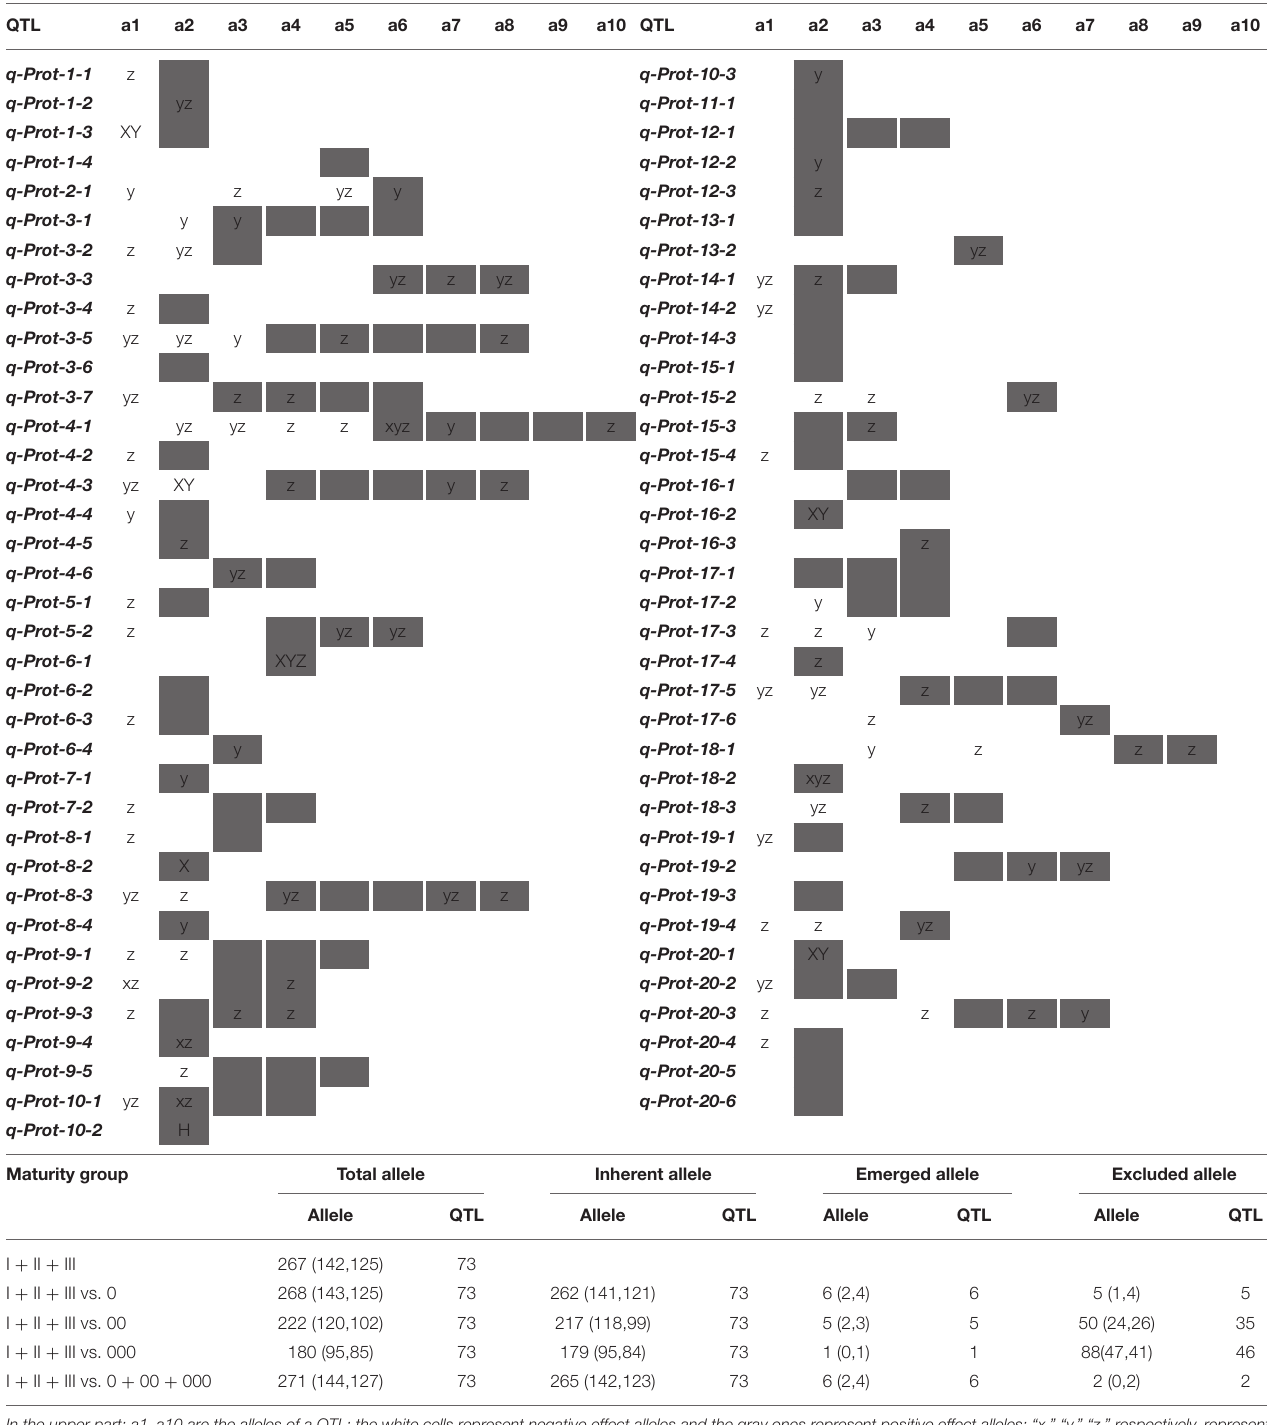
TABLE 3 | The SPC QTL-allele changes among maturity